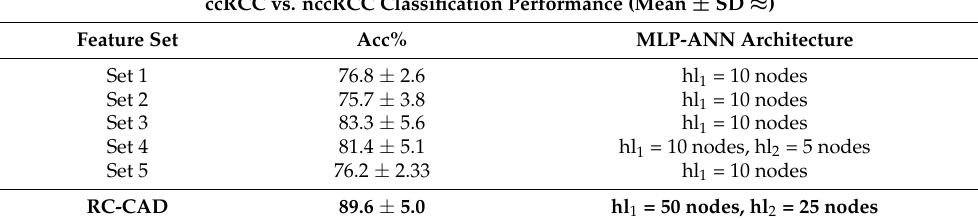
Hyperparameters: MLP-ANN (optimization function: trainlm, max epochs = 500, goal = 0, max validation failure = 6, min gradient = 10 − 7 , training gain ( µ ): initial µ = 0.001, µ decrease factor = 0.1, µ increase factor = 10, max µ = 1e 10